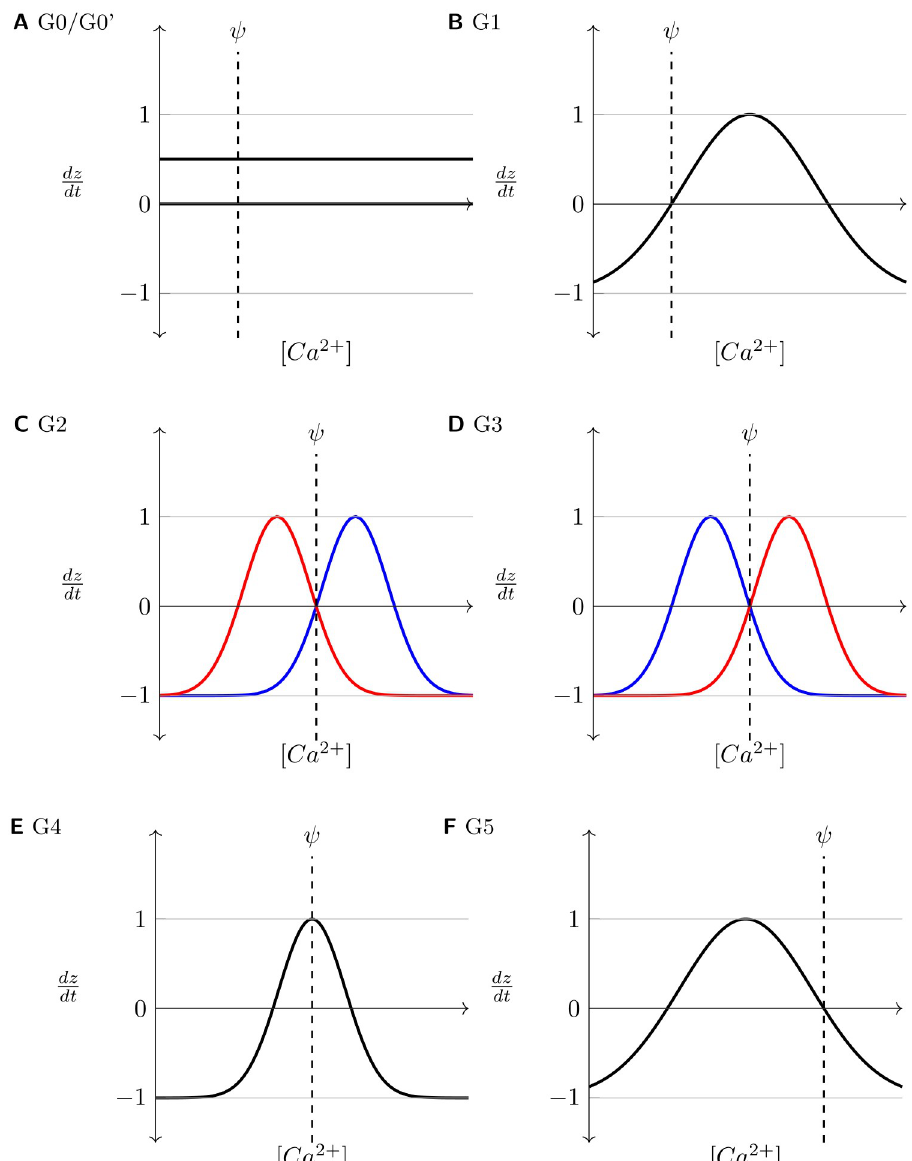
Fig 11. Axonal growth curves investigated in the study (where applicable, Red: Inhibitory, Blue: Excitatory). Only growth curves shown in C/G2 reproduce the course of repair observed in experiments (Table 2). G0 : no growth curves (no sprouting or retraction); G0’ : constant axonal sprouting, irrespective of neuronal activity; G1 : both inhibitory and excitatory axons sprout when activity is more than required; G2 : inhibitory axons sprout when activity is less than optimal, but excitatory axons sprout when activity is more than required; G3 : excitatory axons sprout when activity is less than optimal, but inhibitory axons sprout when activity is more than required; G4 : both excitatory and inhibitory axons sprout at optimal activity. G5 : both inhibitory and excitatory axons sprout when activity is less than optimal.